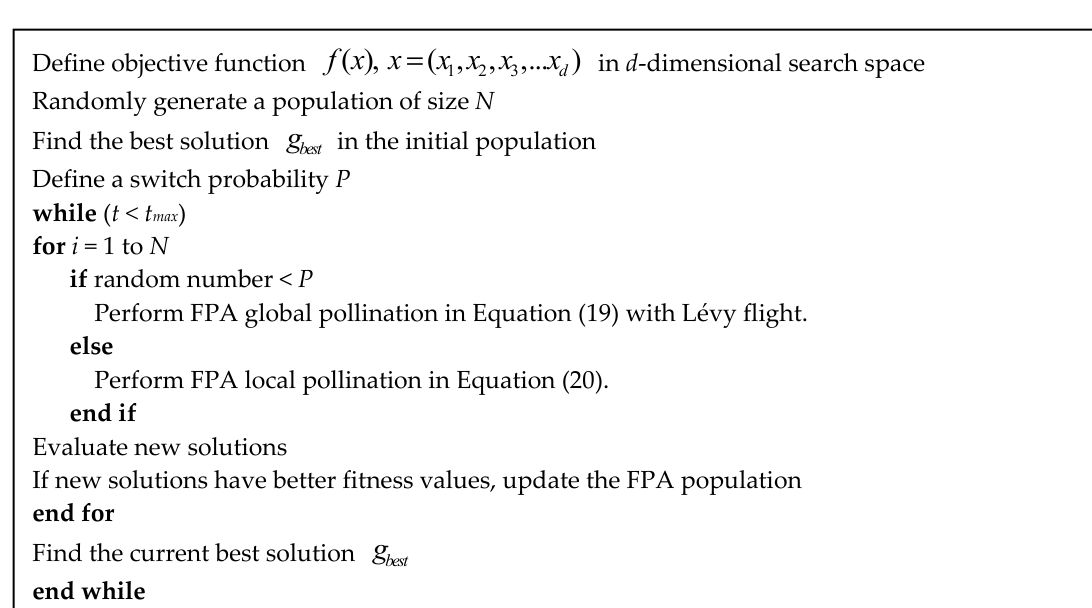
pollination. Figure 2 summarizes the evolutionary FPA machine learning where cross-pollination and self-pollination are respectively mapped into global pollination and local pollination for FPA processes.